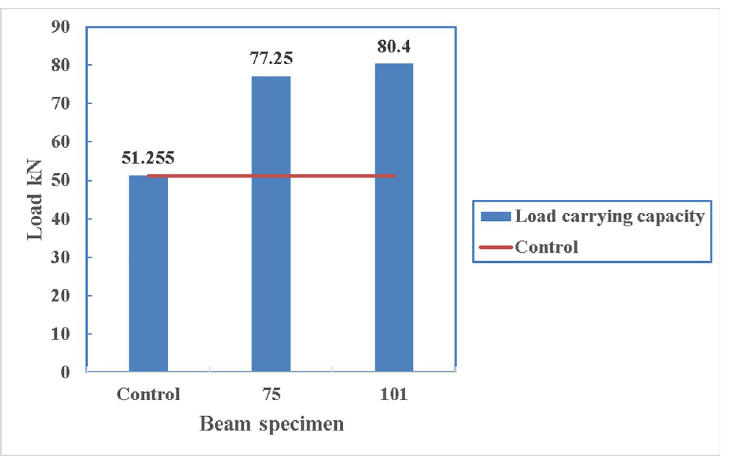
Fig 21. Load- carrying capacity of beams 75 and